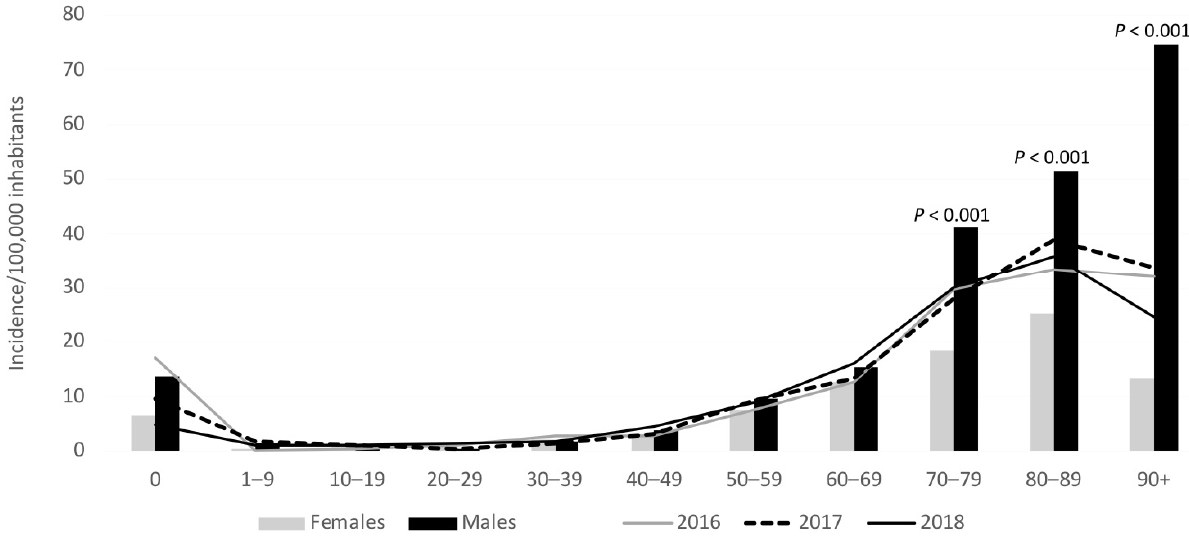
Figure 2. Fungaemia species distribution and incidence per 100,000 inhabitants in 2004 to 2018. * The term non- C. albicans was used from 2004 to 2009.